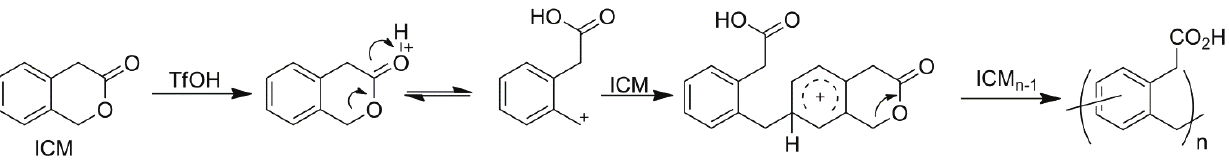
Figure 13. The CROP of